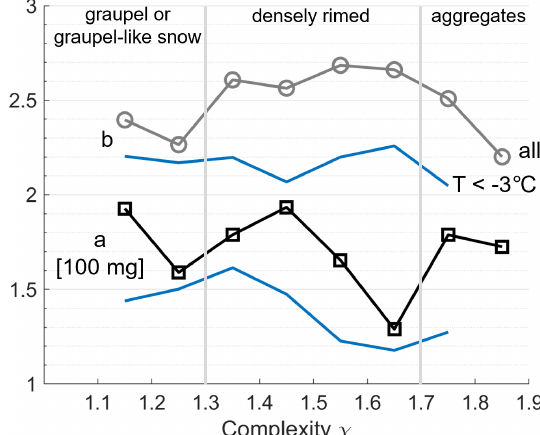
Figure 9. Exponent (gray) and prefactor (black) values in the mass– diameter relationship as binned by 1min average particle complex- ity and filtered by ambient temperature (blue